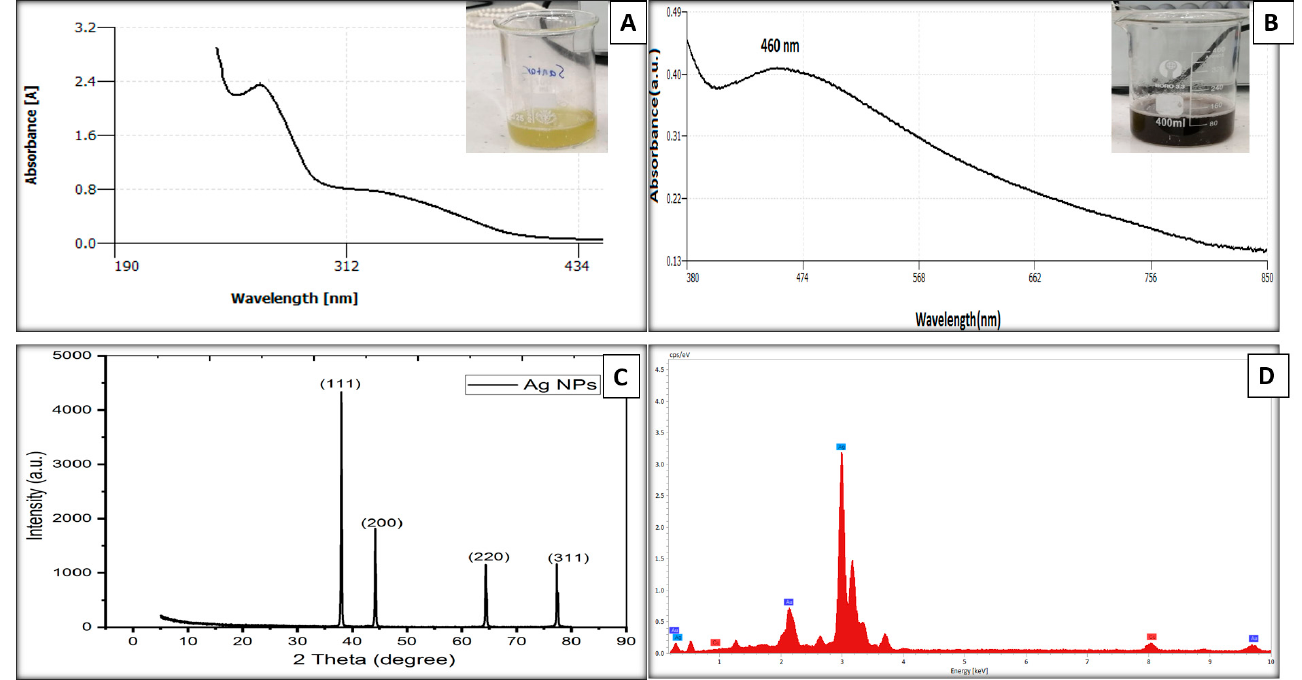
Figure 3. ( A ) UV–Vis absorption spectrum of plant extract, ( B ) UV–Vis absorption spectrum of AgNPs, ( C ) XRD of the Figure 3. ( A ) UV-vis absorption spectrum of plant extract, ( B ) UV-vis absorption spectrum of AgNPs, biosynthesized Ag NPs, and ( D ) EDX spectrum of green synthesized AgNPs. ( C ) XRD of the biosynthesized Ag NPs, and ( D ) EDX spectrum of green synthesized